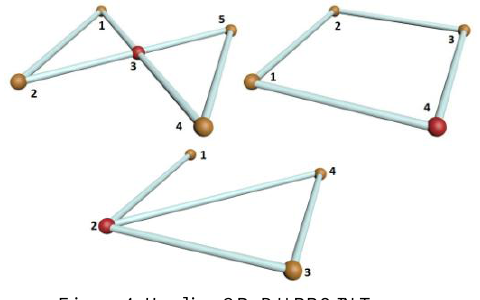
Figure 4. Healing CP_DUPPOINT error